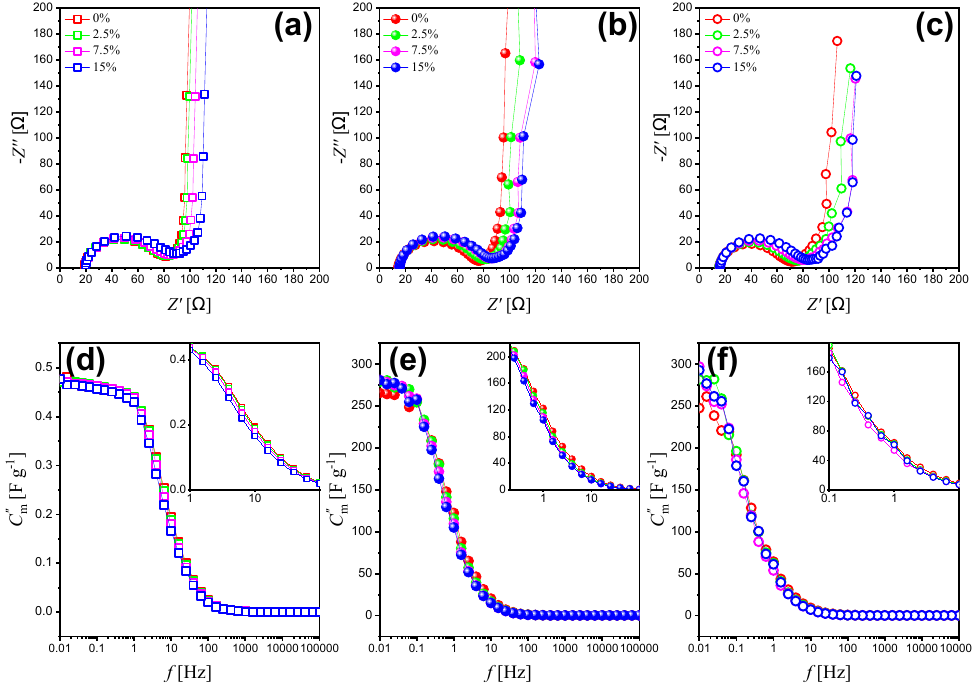
Figure 4. ( a – c ) Nyquist plots of bare NPG, NPG/PPy(10 nm), and NPG/PPy(30 nm) under various de- formations and their corresponding Bode Plots ( d – f ) with capacitance calculated from the imaginary part of impedance. Open square, closed symbol, and open circle represent NPG, NPG/PPy(10 nm), and NPG/PPy(30 nm), respectively. The color conventions indicate the deformation. Insets in ( d – f ) show Bode Plots of middle frequency range at a higher